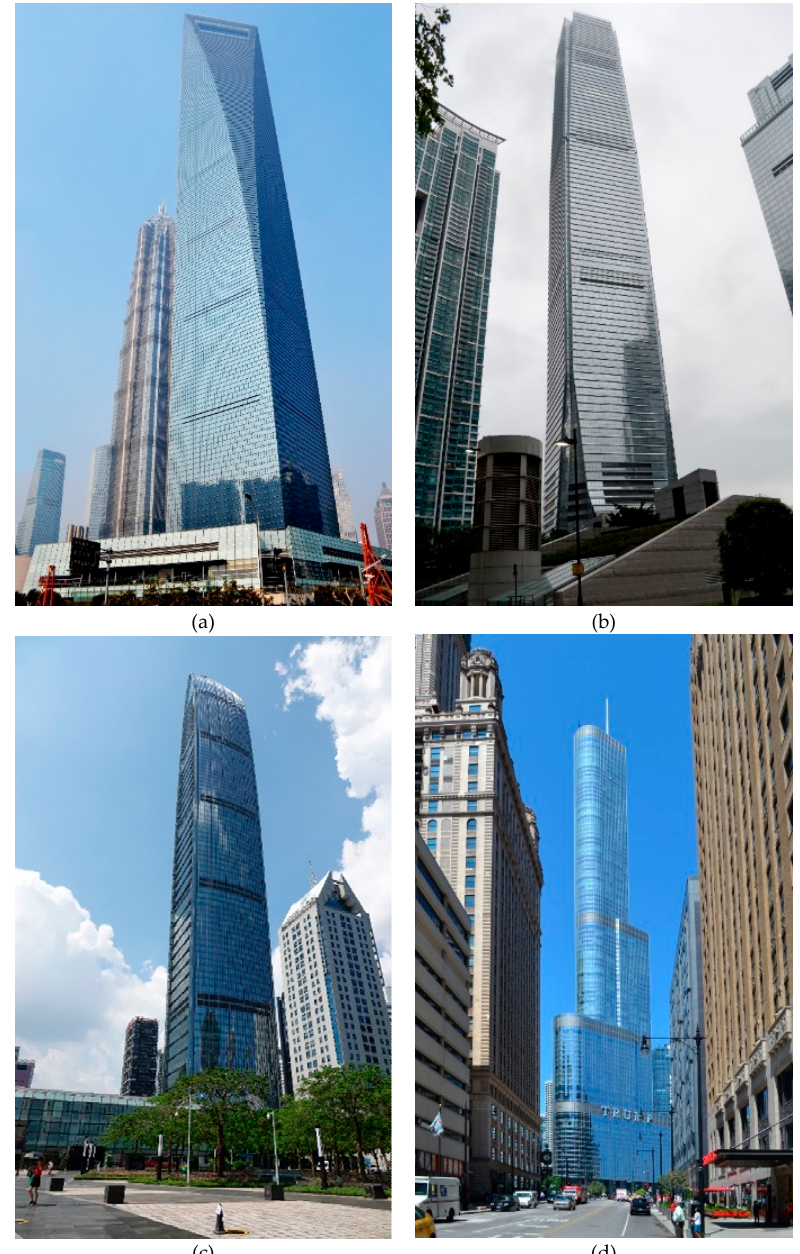
Figure 2. Examples of the world’s tallest buildings built in the 21st Century: ( a ) Shanghai World Financial Center (492 m), ( b ) International Commerce Center (484 m), ( c ) KK 100 (441 m), and ( d ) Trump International Hotel & Tower (423 m) (Photographs by